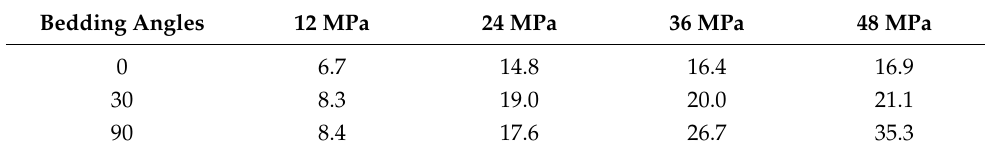
Table 10. Instantaneous elastic modulus of rock samples in a saturated state at different stress levels. Bedding Angles